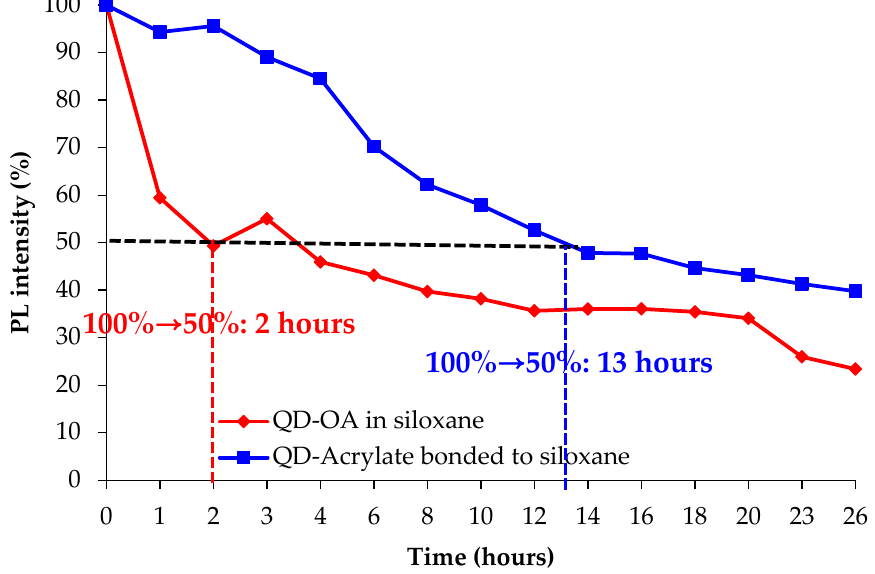
Figure 7. Changes in optical properties of the QD matrices during colour conversion on the blue light-emitting diode